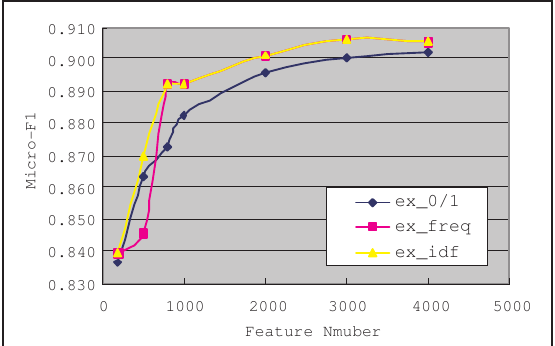
Fig. 5. Comparison on text representation